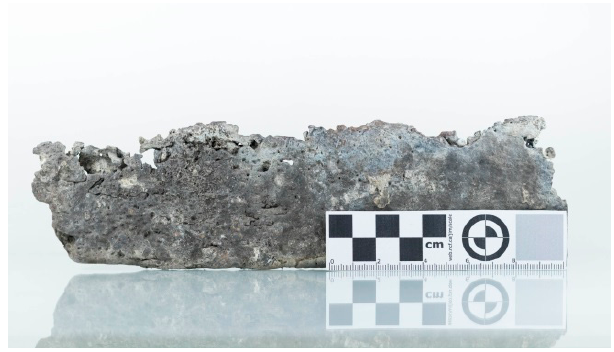
Figure 10. Lead plate used to connect the stone blocks of the monument.